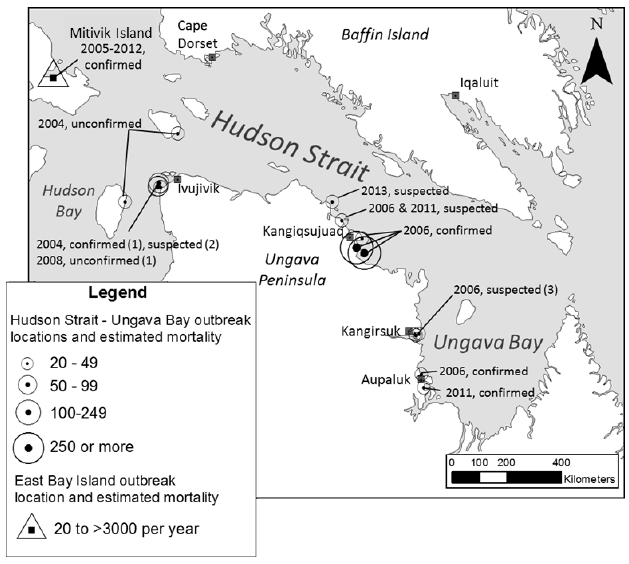
Fig. 2 . Locations in the Hudson Strait region of the Canadian Arctic with confirmed, suspected, and unconfirmed (i.e., Inuit- reported but not independently validated) Avian Cholera